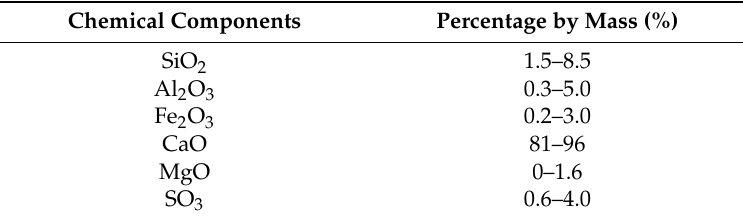
Table 2. Chemical composition of SCDA [37,39,42].